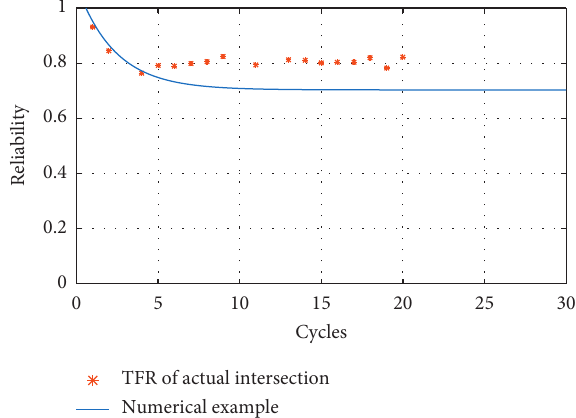
Figure 11: Traffic function reliability of actual intersection for a saturation of 0.3 and in numerical example with a saturation of